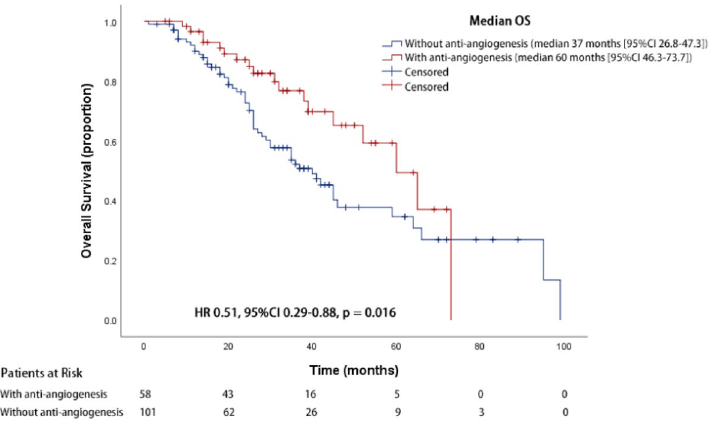
Figure 1. Kaplan–Meier survival curve of overall survival for patients treated with or without anti-angiogenesis therapy.